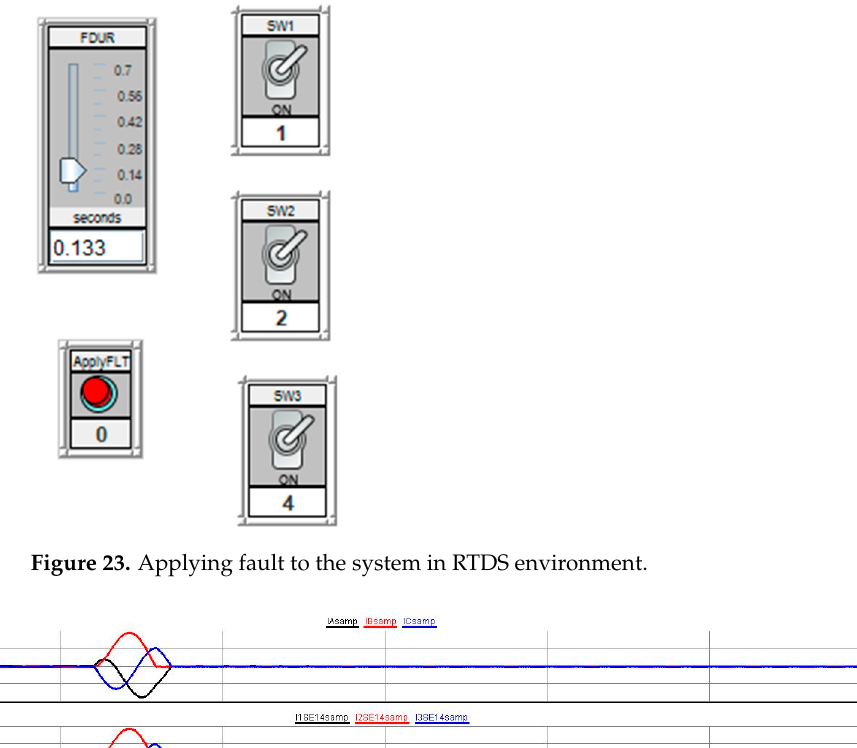
Figure 22. Voltage at bus 1 preceding the fault.